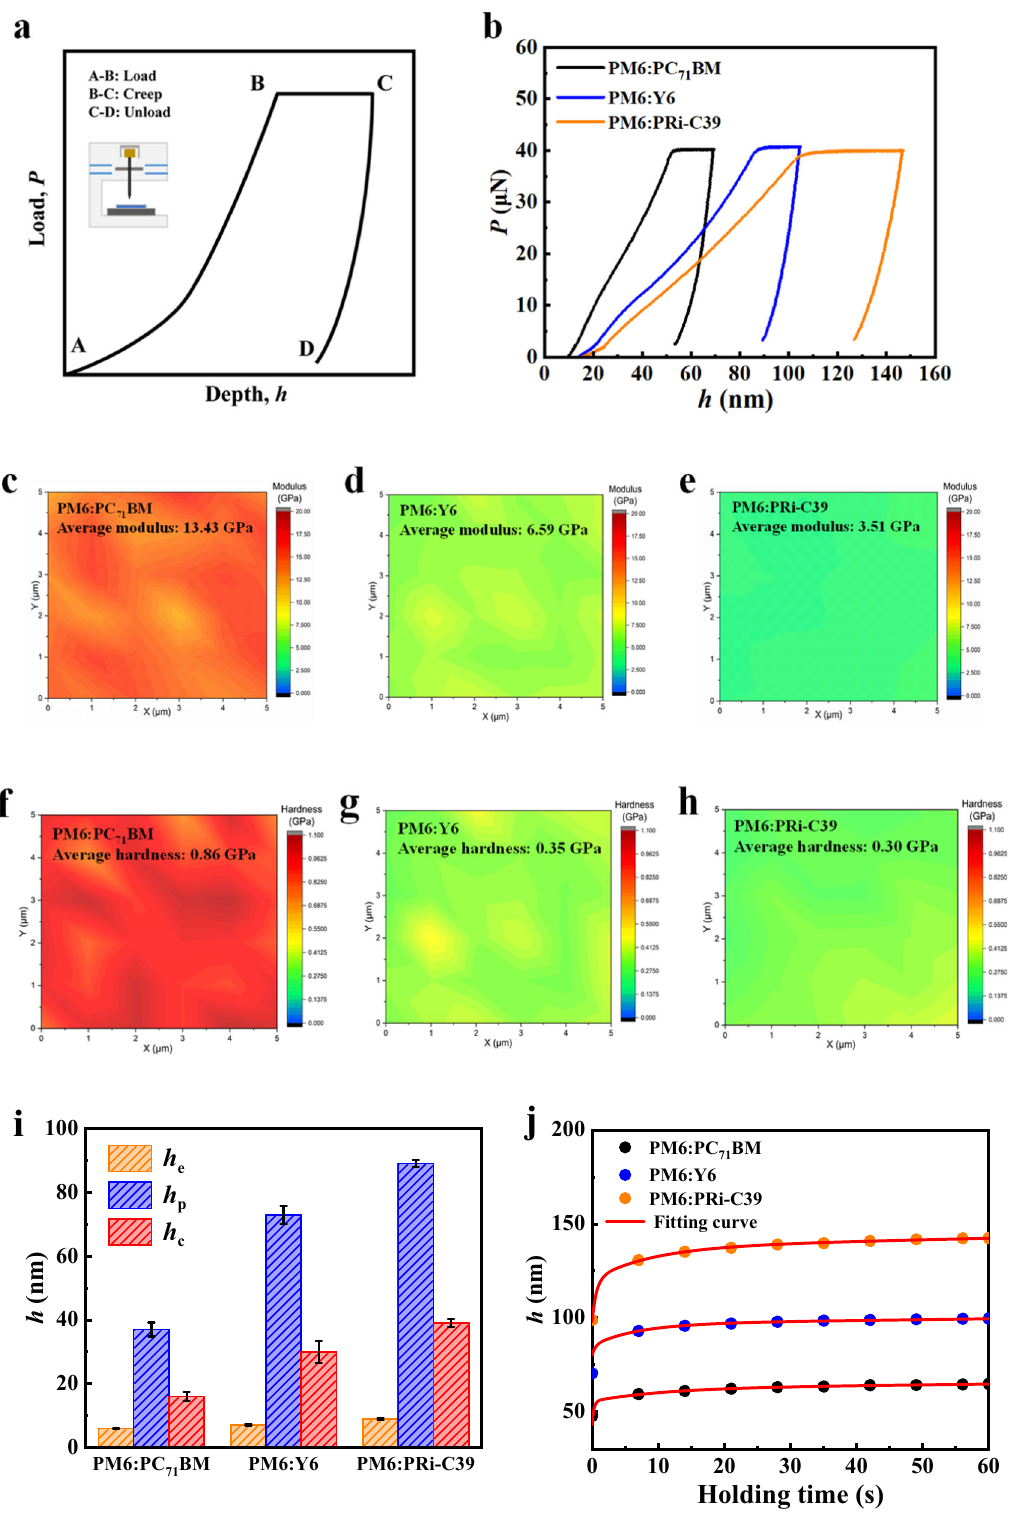
Fig. 3 Nanoindentation test results of the BHJ fi lms. a The schematic diagram of the nanoindentation test together with a typical load versus displacement ( P − h ) curve. b The representative P − h curves of active layer fi lms based on different electron acceptors. The modulus distributions of c PM6:PC 71 BM, d PM6:Y6, and e PM6:PRi-C39 fi lms. The hardness distributions of f PM6:PC 71 BM, g PM6:Y6, and h PM6:PRi-C39 − h curves. Data are presented as mean ± SD. j Changes of indentation fi lms. i The extracted statistical values of h e , h p , and h c from the P displacement with time during